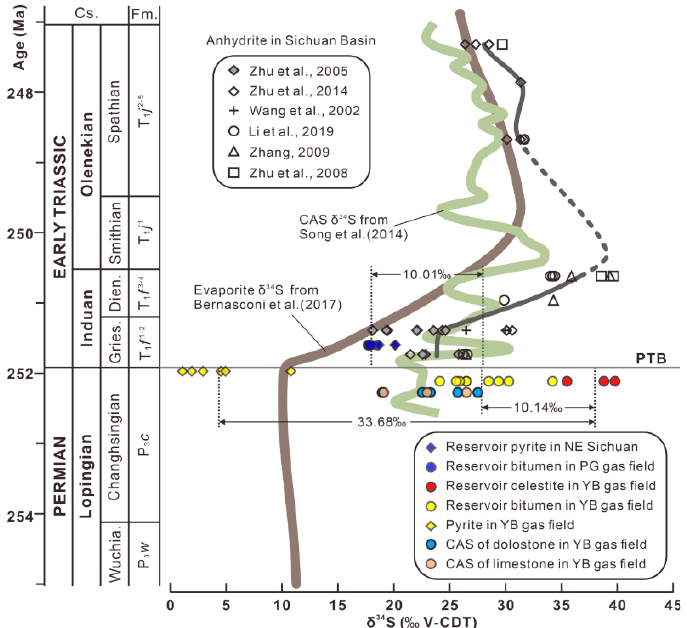
Figure 10. Comparison of δ 34 S values for reservoir celestites, pyrites [8,58], and bitumens [26] in the P 3 c and T 1 f , Pyrites in PTB, CAS in the P 3 c carbonates in the YB gas field, the Lower Triassic anhydrites in the Sichuan Basin [8,26,58–61], and the Late Permian and Early Triassic seawater [55,62]. The approximate correspondence between stratigraphy and geologic age is referred to un Xu et al. [63]. Cs., Chronostratigraphy; Fm., Formation; Wuchia., Wuchiapingian; Gries., Griesbachian; Dien., Dienerian.